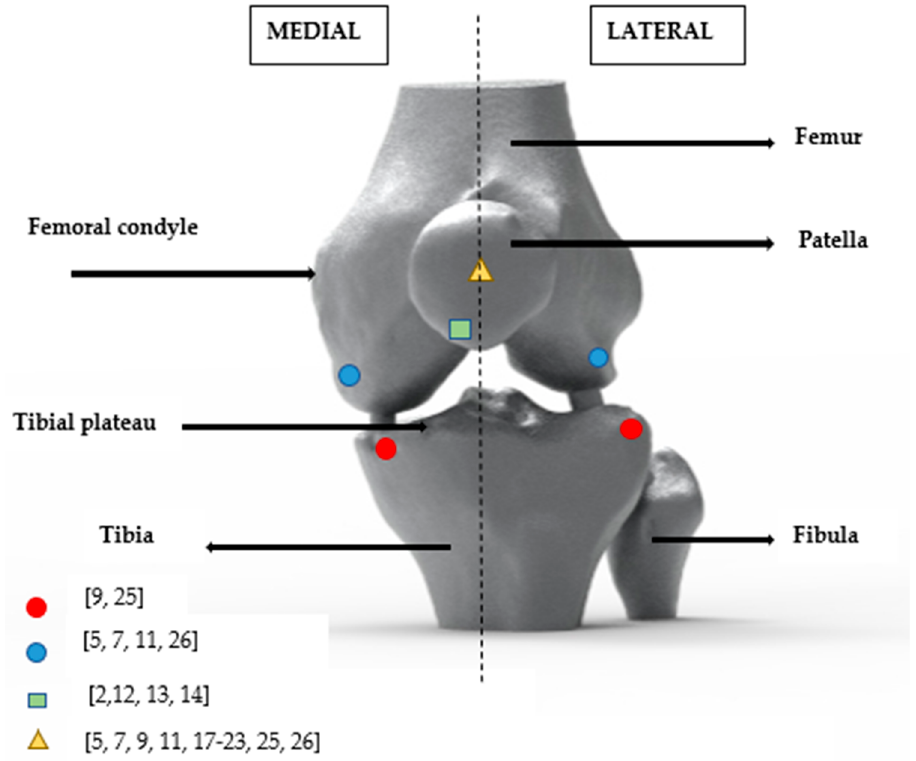
Figure 1. 3D modelling of a left knee with color symbols showing the different locations of sensors used by the authors.